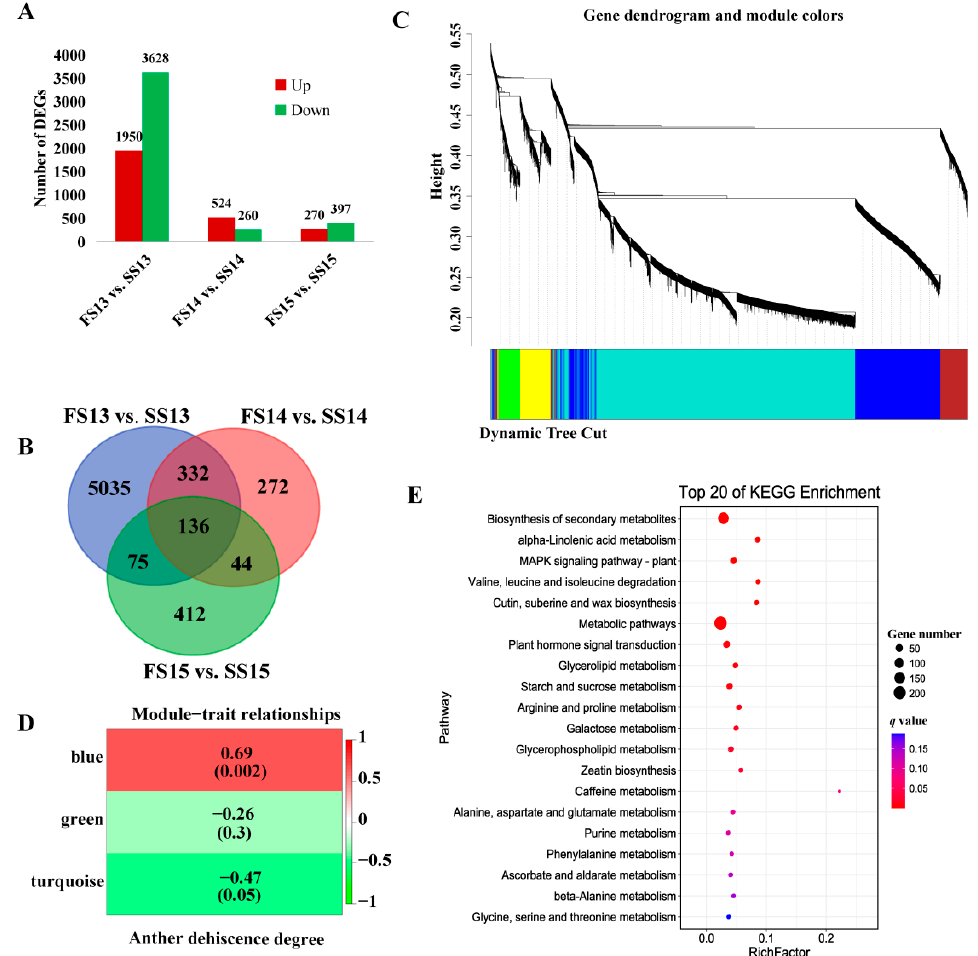
Figure 2. Identification of differentially expressed genes and weighted gene co-expression network analysis of DEGs. ( A ) Analysis of DEGs between fertile and sterile conditions in BS366. ( B ) Venn of different stages of DEGs between fertile and sterile conditions. ( C ) Genes of dendrogram and module colors of the WGCNA. ( D ) Module–trait relationships of the WGCNA. The blue module, green module, and turquoise module represent three modules from Figure 2C. The colors of panels show a color scale for module–trait relationships ranging from − 1 to 1. ( E ) The top20 of KEGG enrichment of the DEGs of the blue module of Table 1. Statistical results of RNA sequencing data.